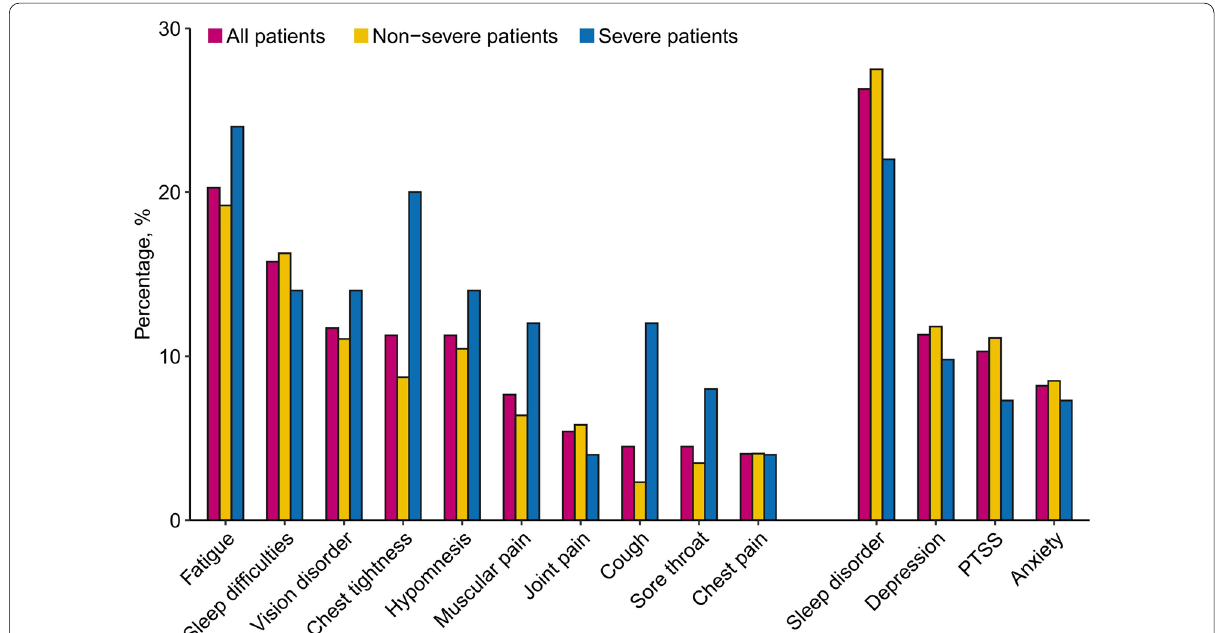
Fig. 2 Percentage of ten common general symptoms and psychological symptoms in recovery patients with COVID-19 at 1-year follow-up. PTSS, post-traumatic stress